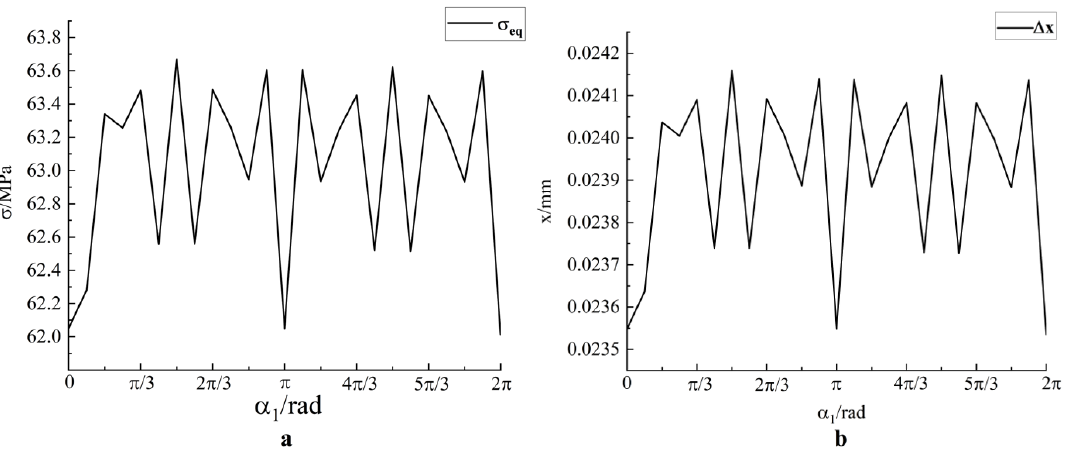
Figure 18. ( a ) Diagram of maximum equivalent stress of crankshaft under 25 working conditions. ( b ) Diagram of maximum shape variable of the crankshaft under 25 working conditions.